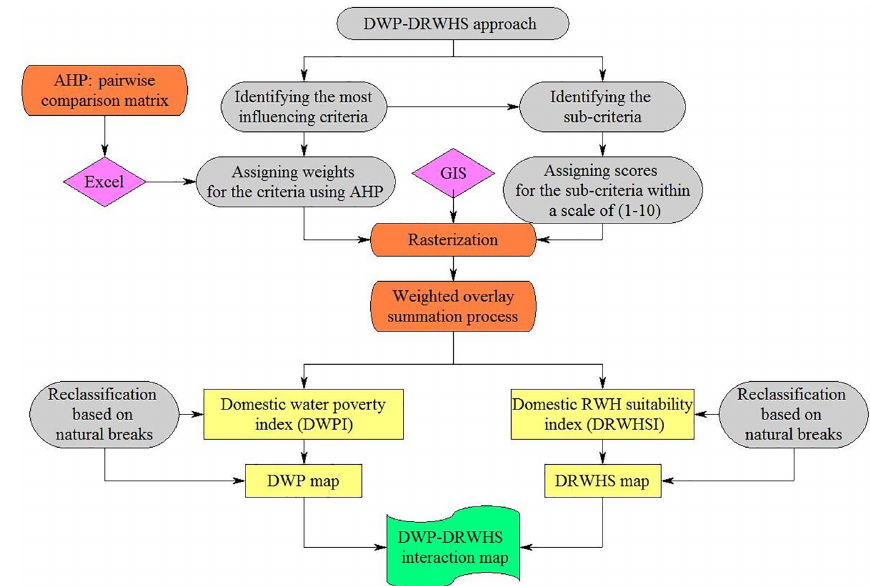
Figure 2. Methodological framework for developing DWP and DRWHS maps.